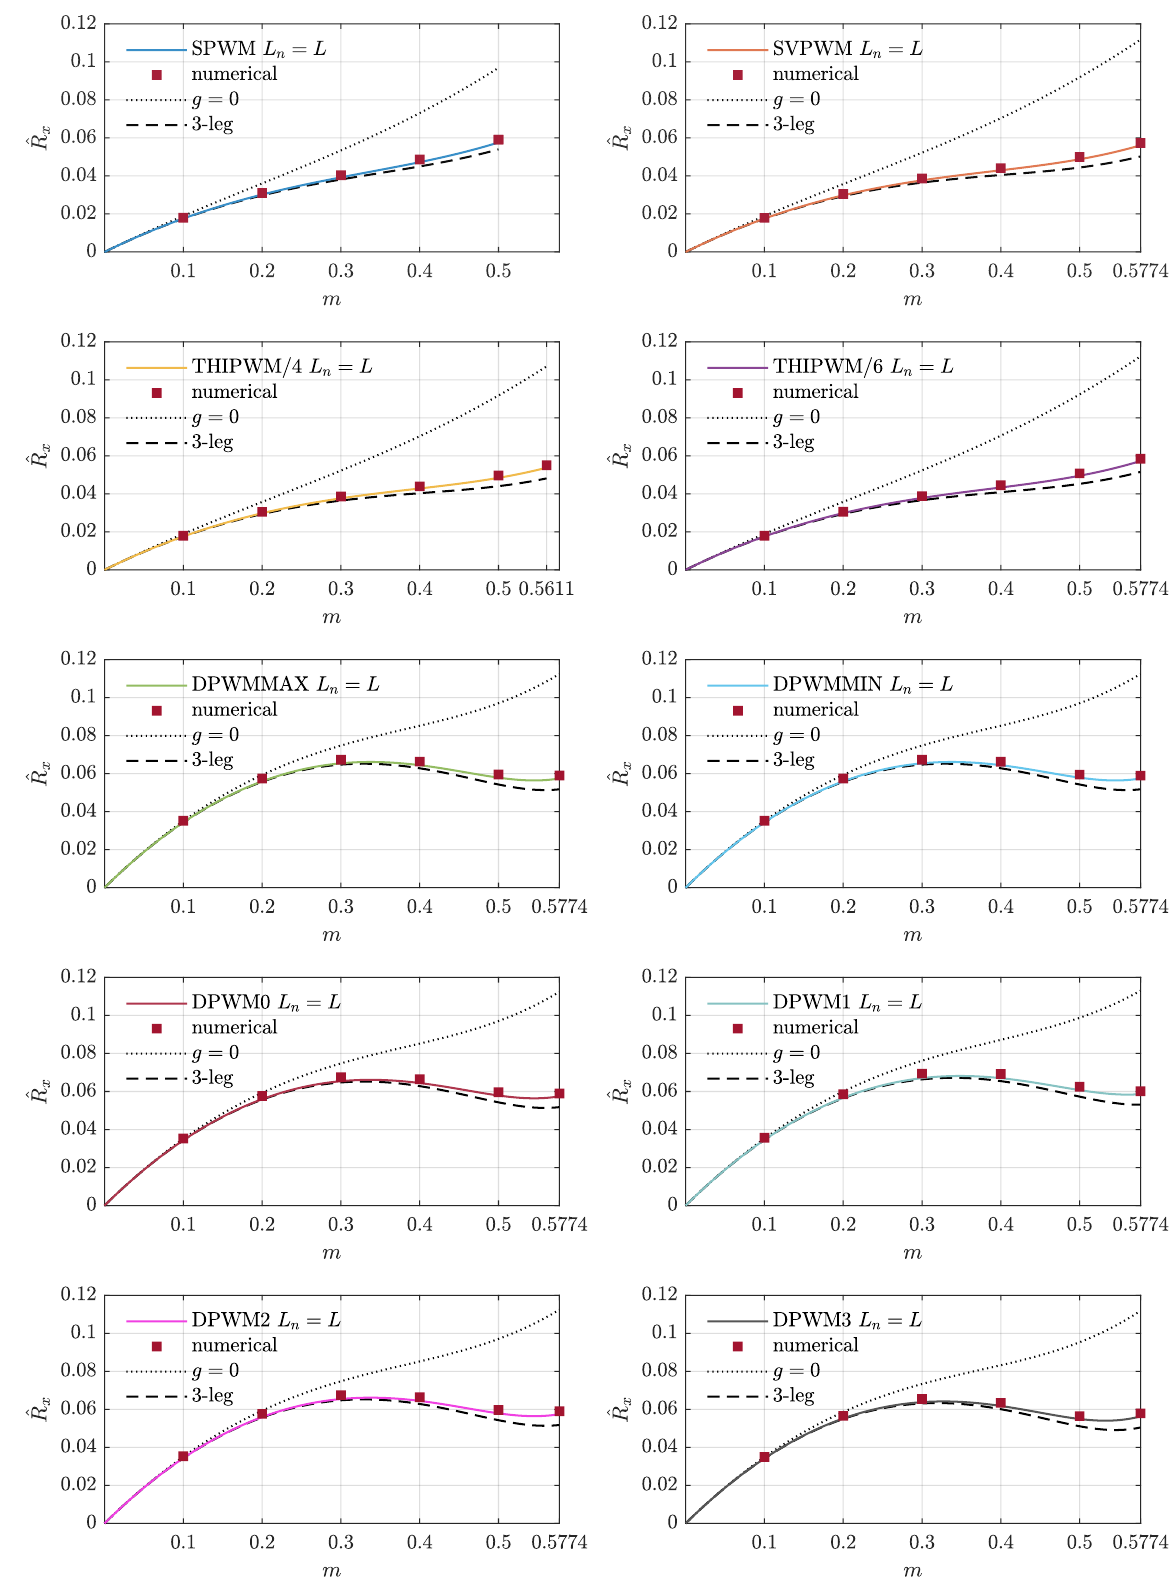
Figure 4. Numerical validation of normalized phase-current-ripple RMS in the case of multiple PWM common-mode injections for L n = L (i.e., g = 1). Normalization base V dc / ( 2 Lf sw )